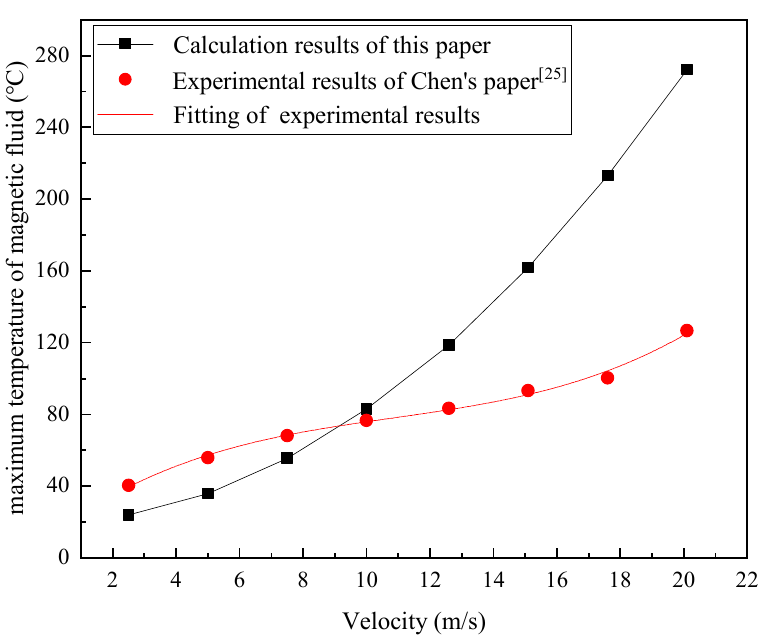
Figure 7. Comparison of the calculation results of magnetic fluid temperatures in the sealing gap herein, with the experimental results measured by another individual, at different linear velocities.